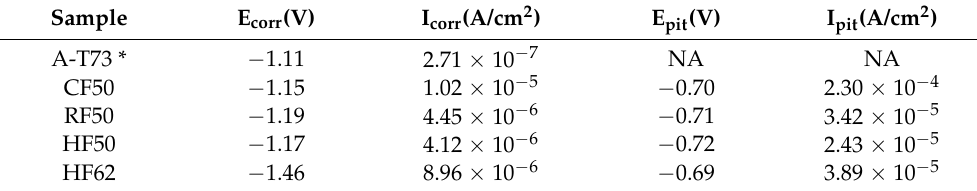
Figure 10. High angle grain boundaries (>15°) measured from RF50. Table 4. Polarization Curves for Different Samples Immersed in a 3.5 wt.% NaCl Solution. Sample